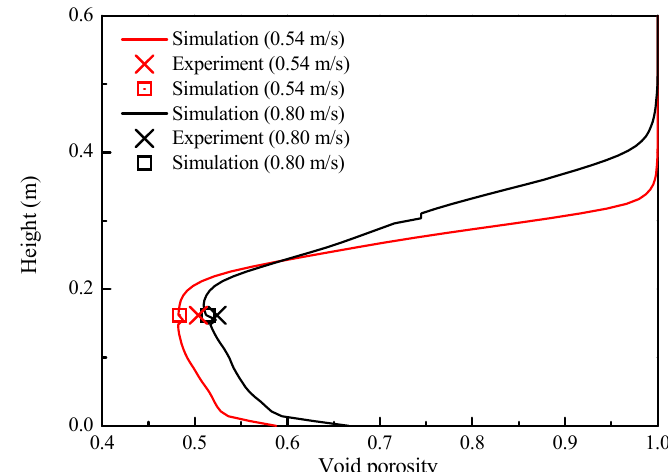
Figure 8. Average cross-sectional void porosity along the axial height for 0.54 m/s and 0.8 m/s (experiment: the average cross-sectional void porosity at the axial height 0.143–0.181 m).